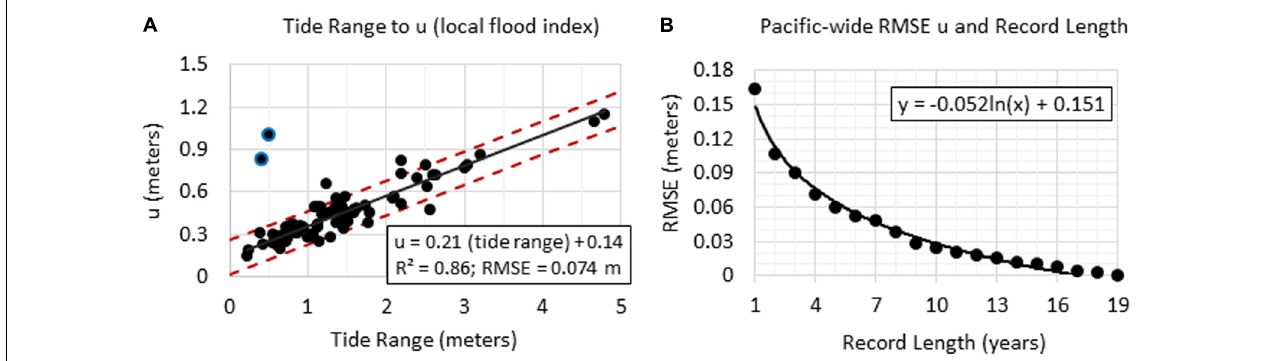
FIGURE 4 | (A) Tide range and u (local RFA local flood index and TG exceedance threshold) and linear regression fit statistics with two outlier TGs (Nome and Minamito > 2 stdev) not included in the regression. In (B) is the root mean square error (RMSE) for estimates of u based upon 1–19 years of consecutive data over the 2001–2019 period based upon 64 of the 84 TGs used in this